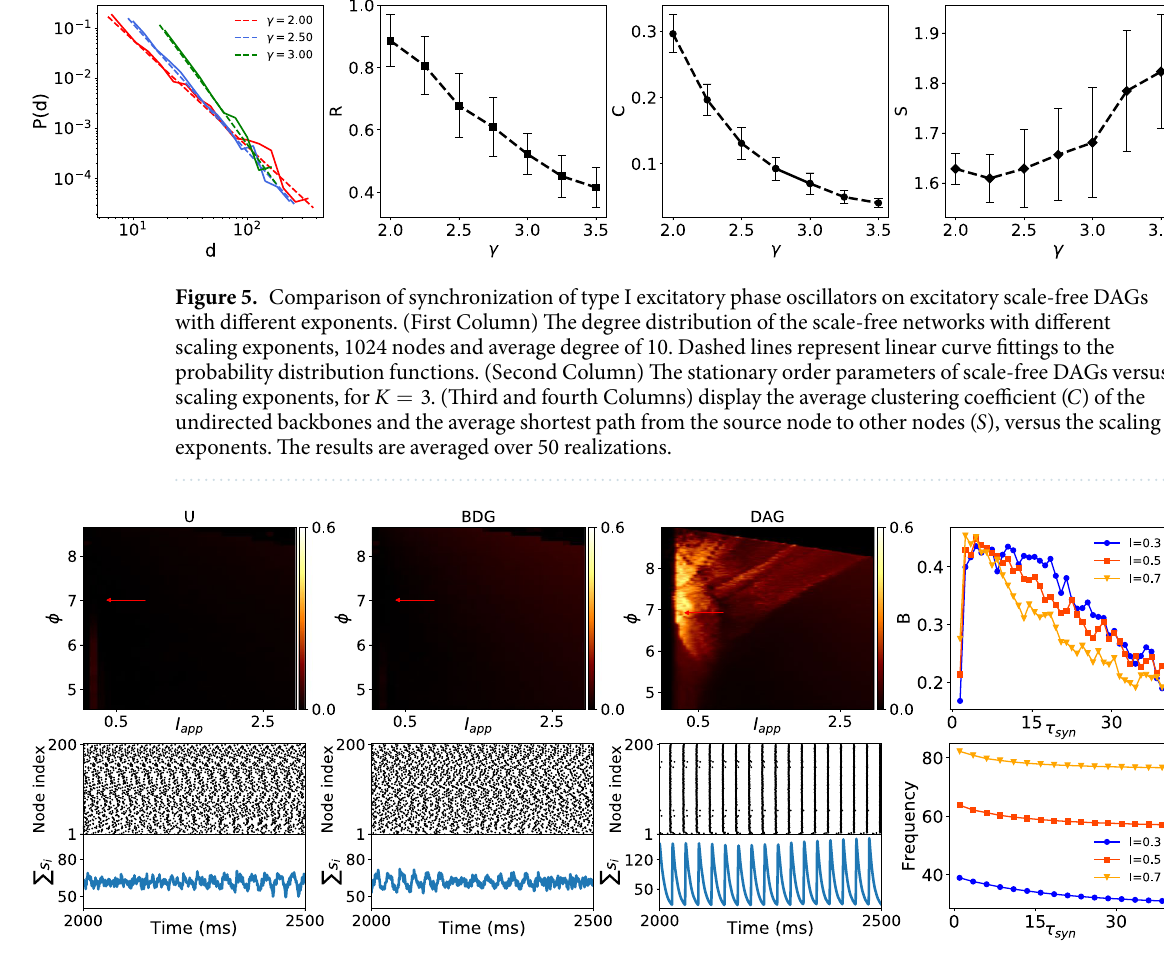
Figure 6. Synchronization of Wang-Buzsáki inhibitory neurons coupled via scale-free undirected and directed graphs. (First three columns) Top panels display the interspike distance synchrony of the networks on φ − I app phase space. Bottom panels represent the raster plots and the sum of the synaptic gates ∑ s for three network i i instances using the parameters specified by the arrows at the top plots. The synapse parameters are 1 1 2 . (Right column) Top and bottom panels show the effects of α β = = . = . − − g 12 ms , 0 1 ms , 0 1 mS/cm syn synaptic time constant ( τ β = 1/ ) on synchrony and frequency of oscillation for different values of applied syn currents, respectively at = . K 1 25 . The parameters of the networks are valued as = N 200 , and γ = 3